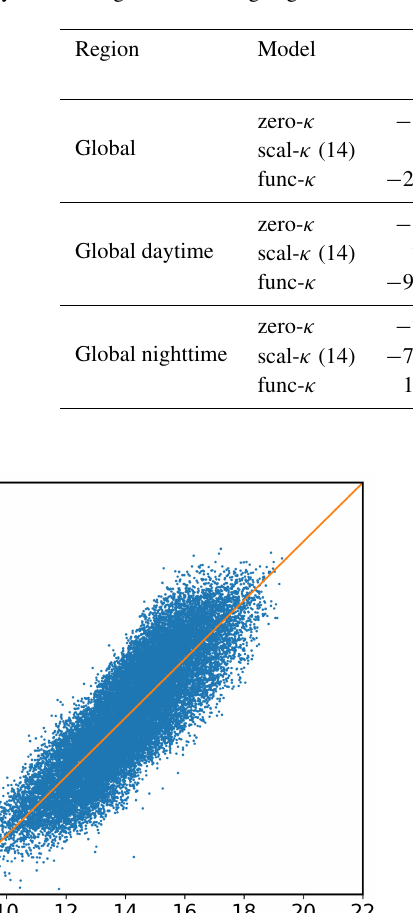
Table 7. Global, daytime and nighttime bending angle errors for three models